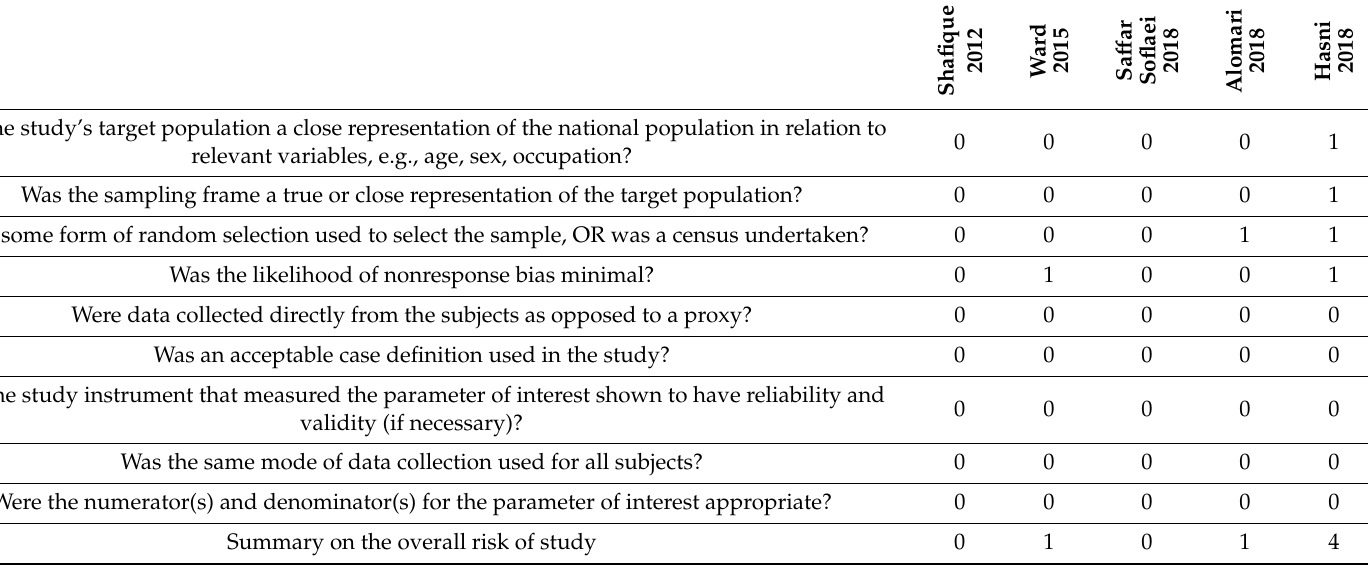
Table 2. Quality assessment checklist for prevalence